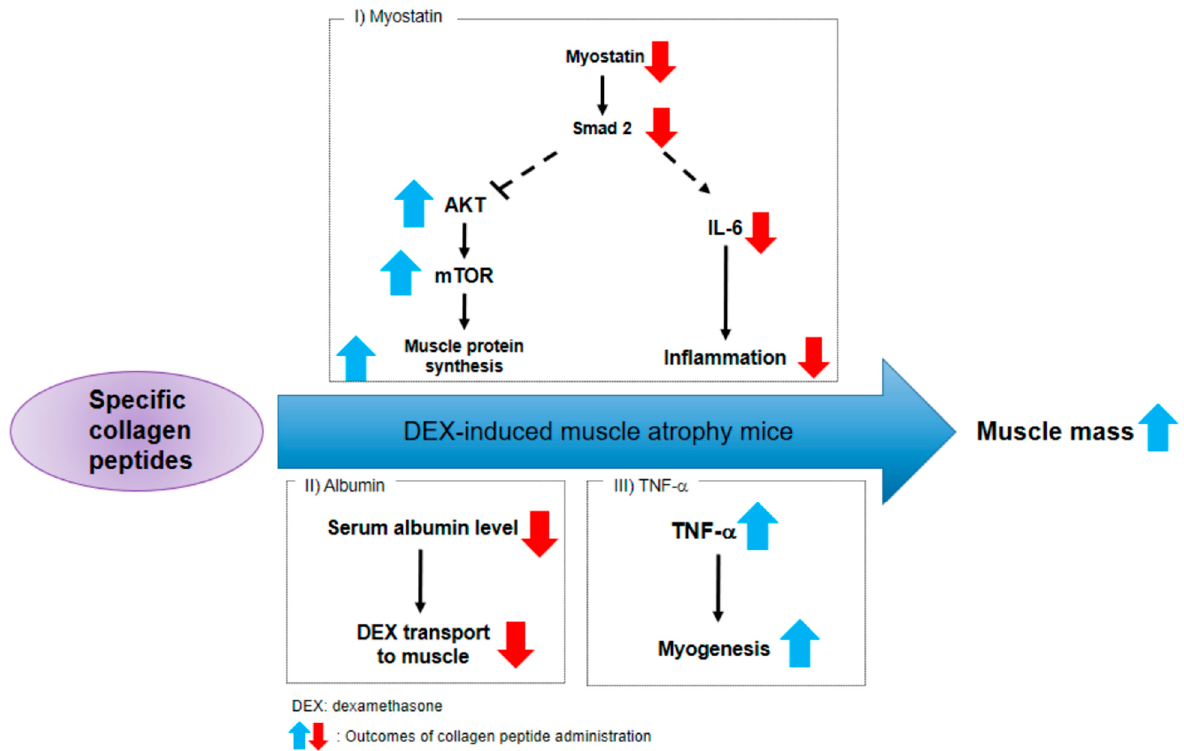
Figure 6. Schematic diagram presenting the mechanism for CP’s anti-muscle atrophy effects.